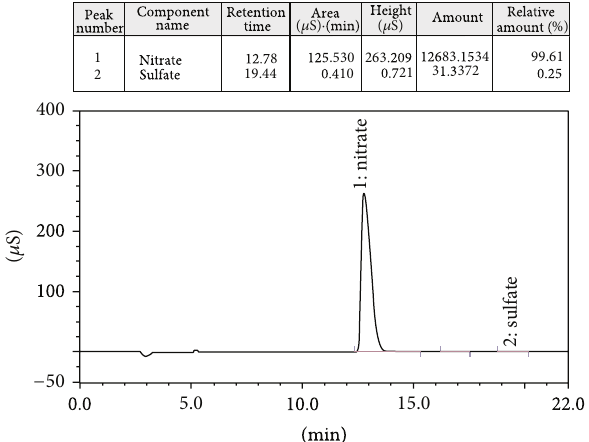
Figure 2: Ion chromatography for ammonium nitrate with 600 ppm sulfuric acid.